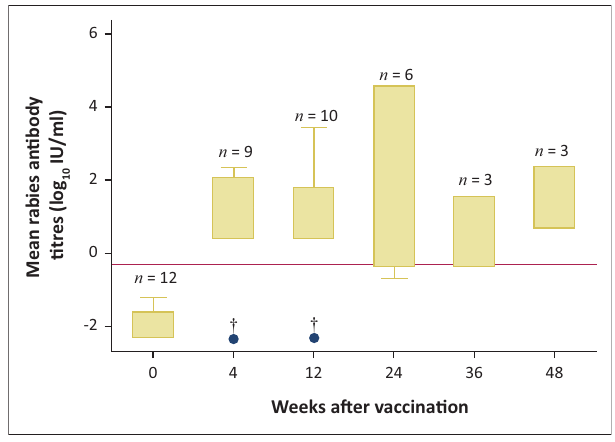
FIGURE 2: Rabies antibody titres in captive black-backed jackals ( n = 12) given Raboral VR-G  oral rabies vaccine. Red reference line = adequate antibody titre (0.5